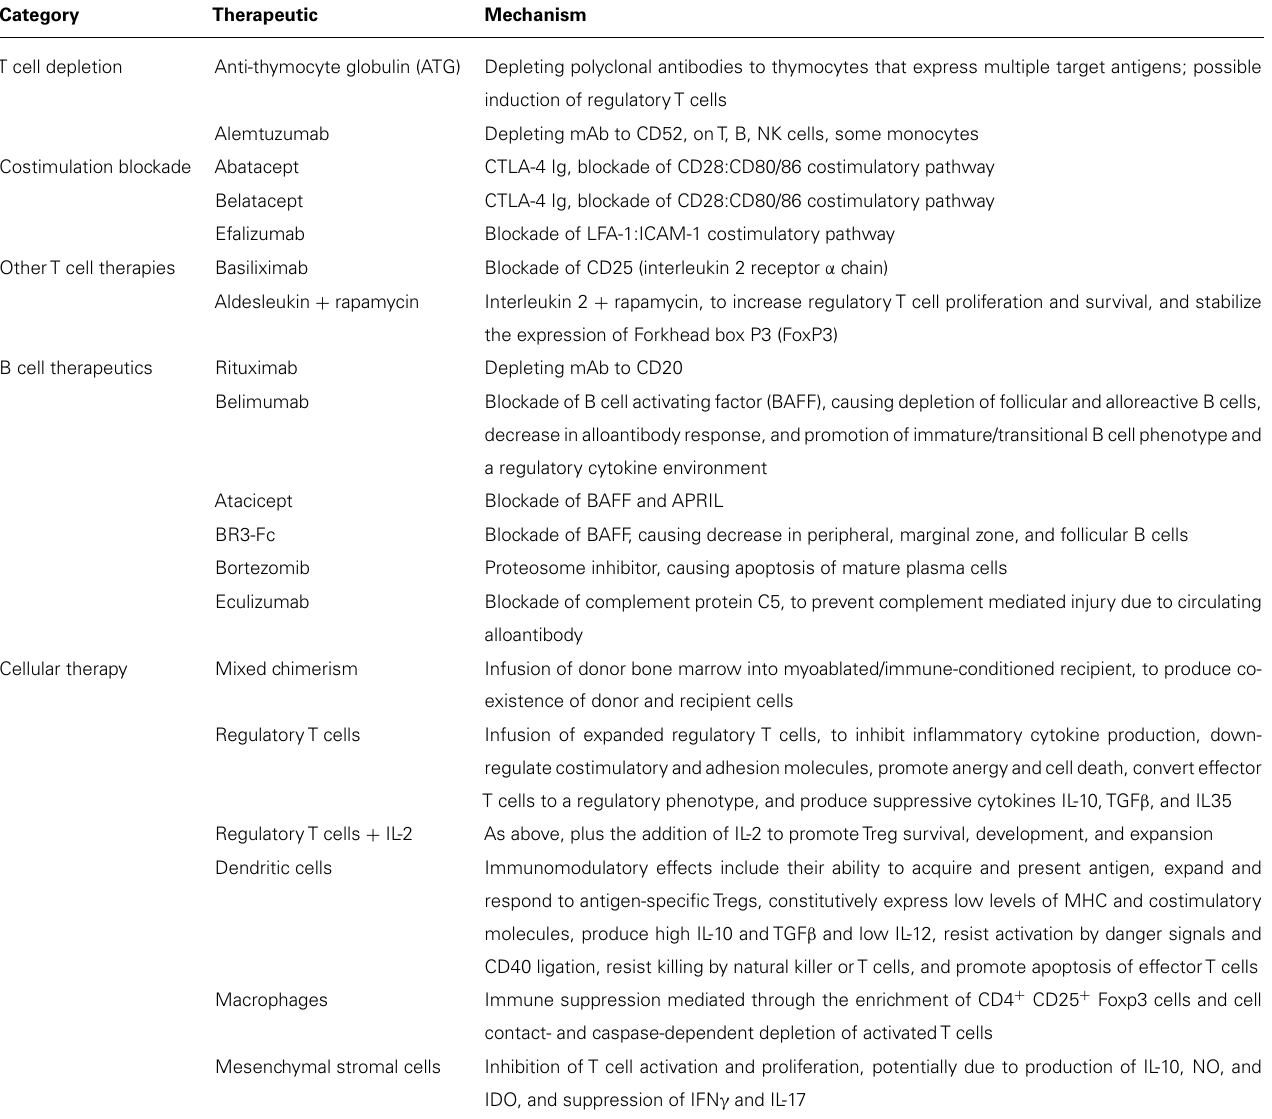
Table 1 | Strategies for tolerance induction.This table outlines the pharmacologic, biologic, and cellular therapies discussed in this article, categorized byT cell agents, B cell agents, and cellular therapies (including mixed chimerism).